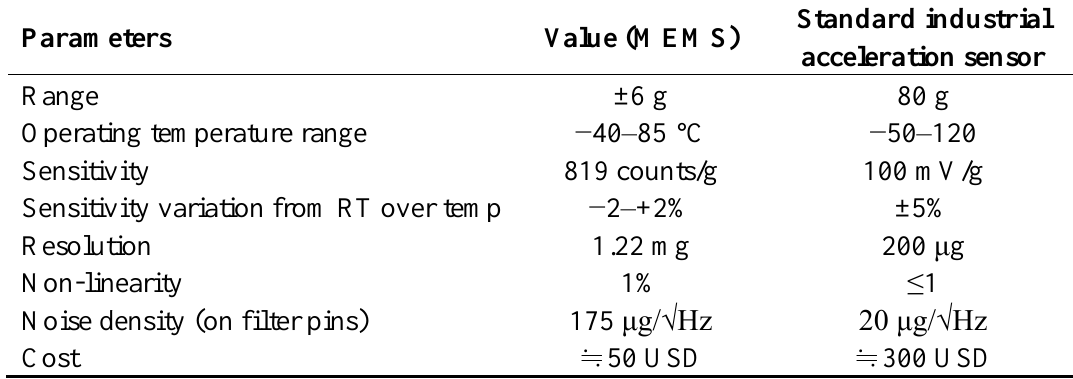
Table 1. Accelerometer specifications [12,13].